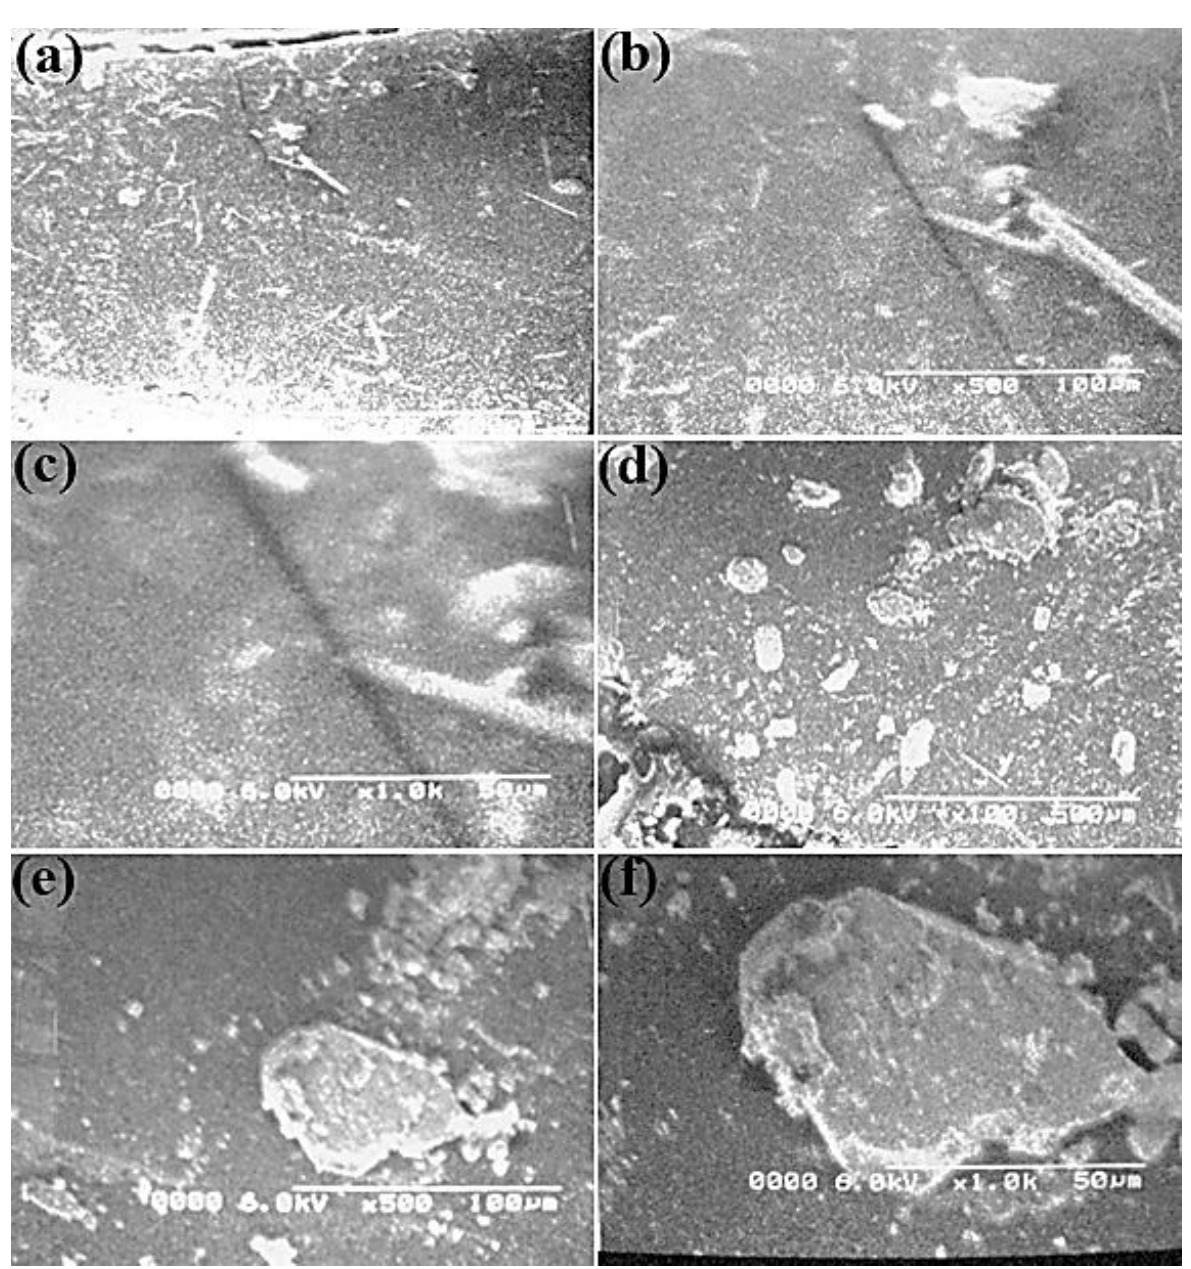
Figure 4. SEM images at different magnifications of POA ( a – c ), and POA with 2% MMT clay ( d – f ).